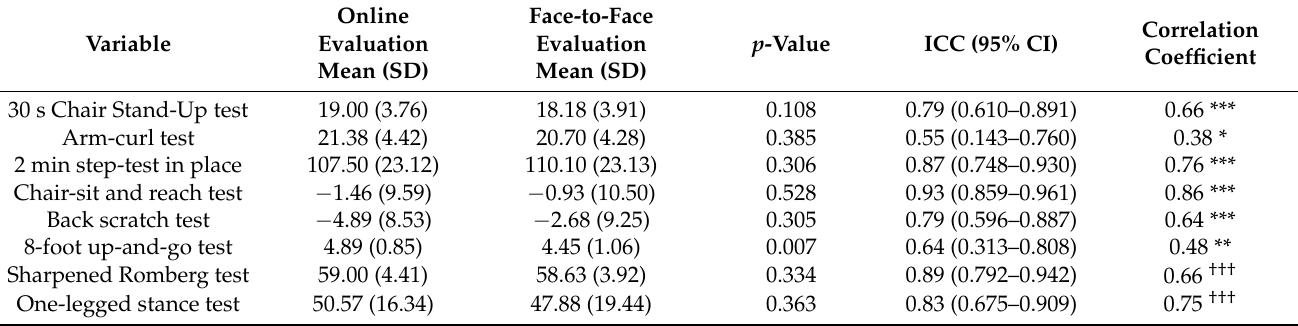
Table 3. Agreement under online and face-to-face evaluations of total sample size (N =